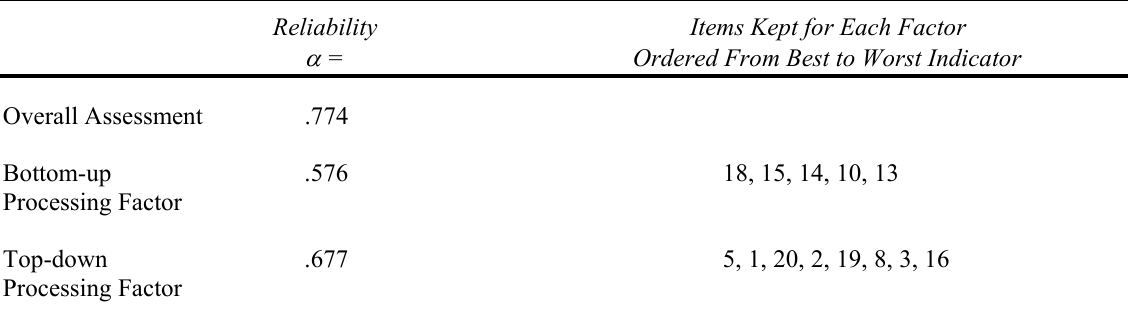
Revised Listening Assessment (13